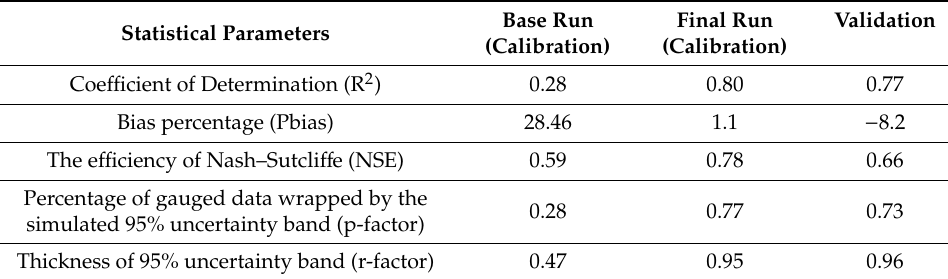
Table 5. Results of calibration and validation using the SUFI-2